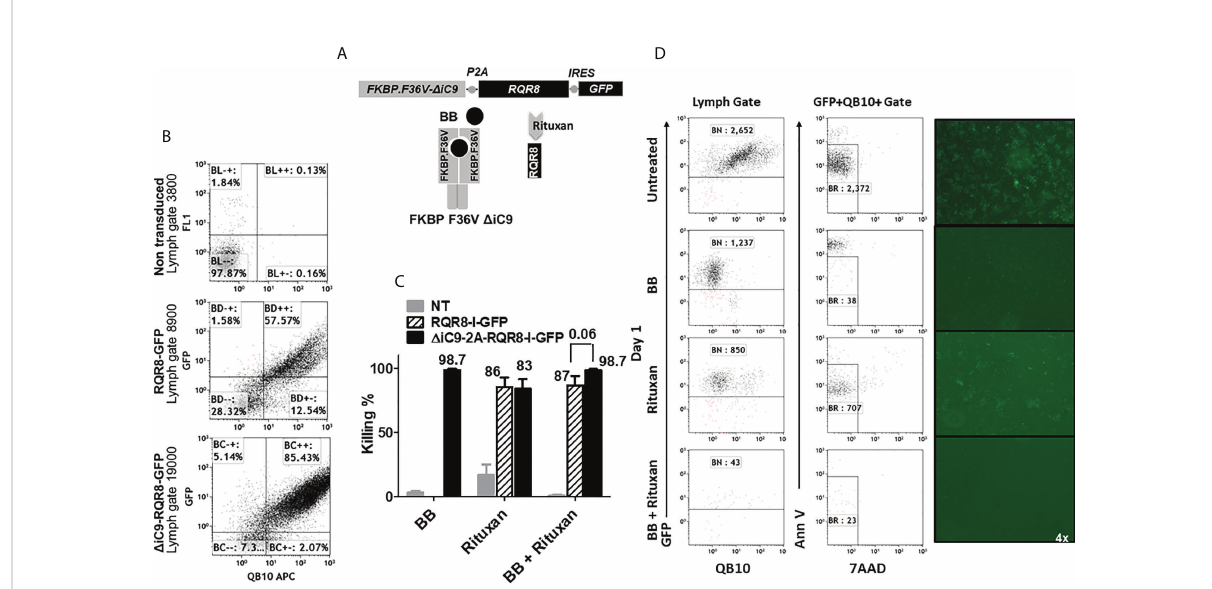
FIGURE 6 (A) Retroviral transgenic construct and protein diagram of D iC9-RQR8-GFP activatable with the BB homodimerizer and the anti-CD20 monoclonal antibody rituxan. 6 (B) Dot-plots of QBend10/GFP expression from a representative experiment. (C) Summary of N: 3-5 killing experiments of Jurkat non-transduced, expressing the RQR8 compact suicide gene or the iC9 and the RQR8 suicide gene in a single construct treated with the BB homodimerizer overnight [100nM], or rituxan [100 ug/mL] for four hours in the presence of rabbit serum complement. (D) . Dot-plot and fl uorescent images from one representative killing